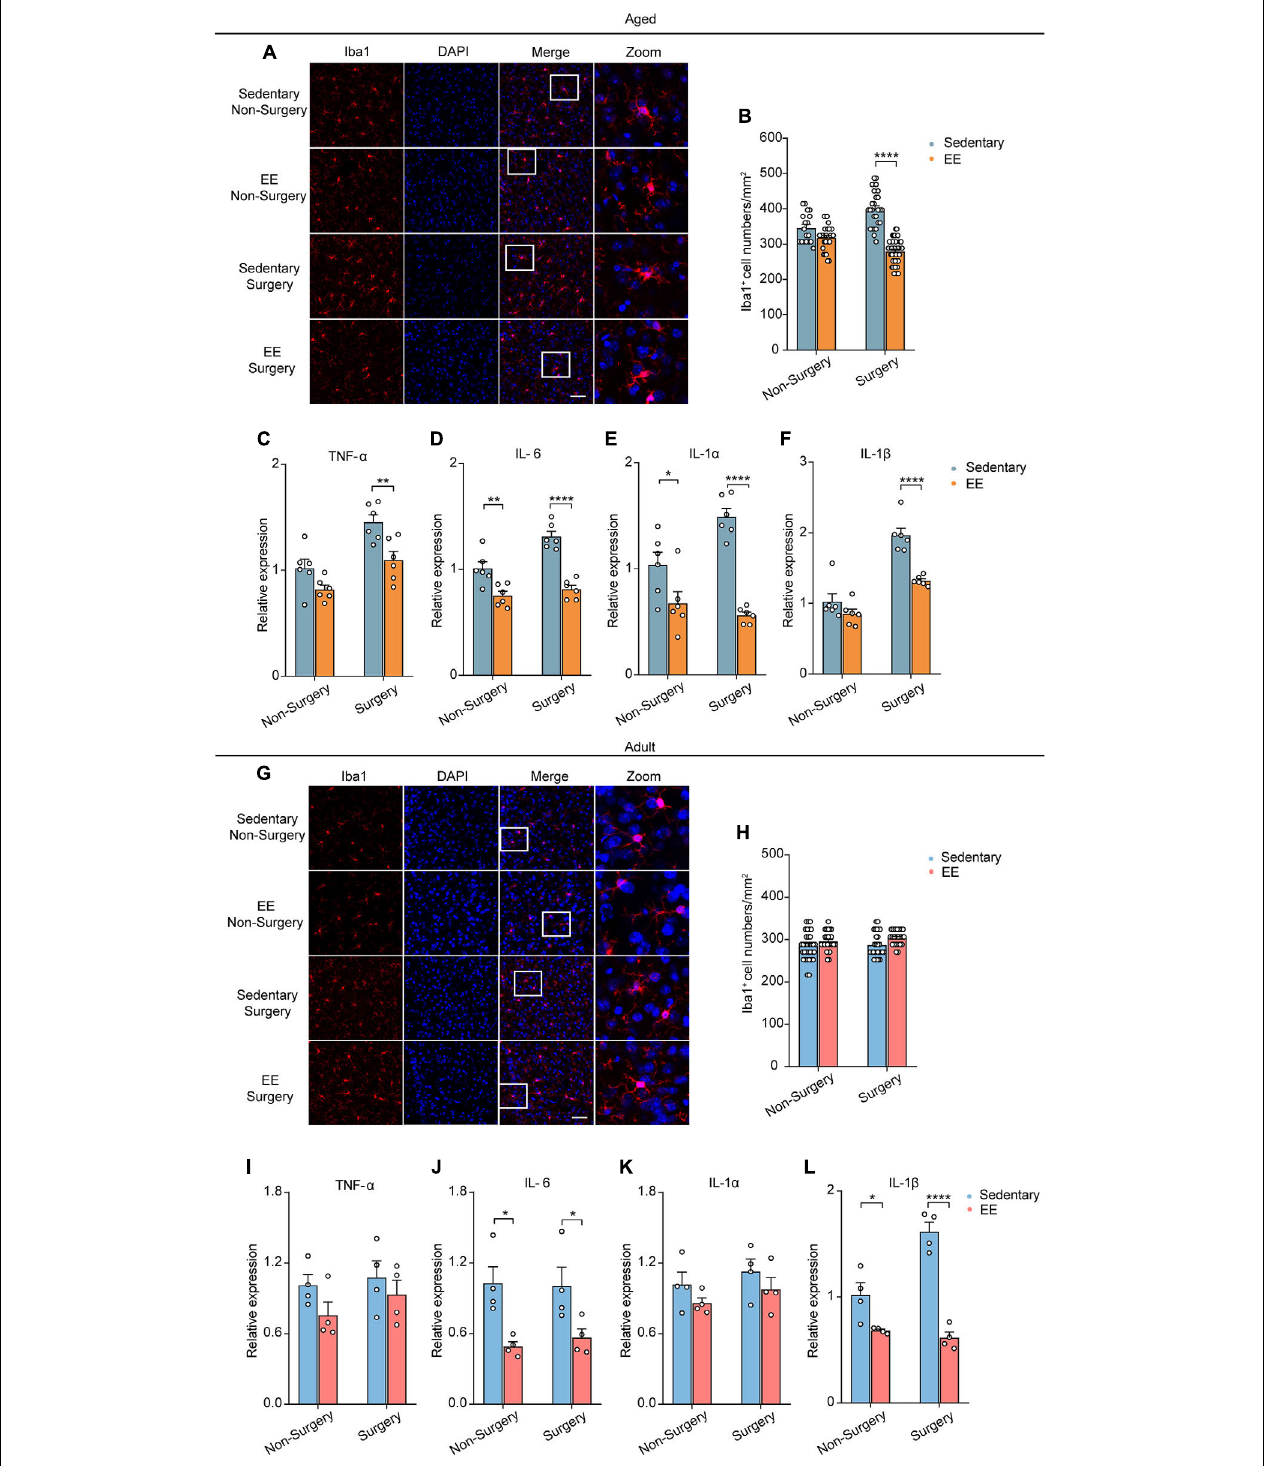
FIGURE 5 | EE prevented the exaggerated neuroinflammation induced by surgery in the aged mice. (A) Representative images of Iba1 + microglia in mPFC of the aged mice in each group. Scale bars: 50 µ m. (B) Quantification of Iba1 + cell numbers in each group of the aged mice. (C–F) Expression level of TNF- α (C) , IL-6 (D) , IL-1 α (E) and IL-1 β (F) in each group ( n = 6 mice). (G) Representative images of Iba1 + microglia in mPFC of the adult mice in each group. Scale bars: 50 µ m. (H) Quantification of Iba1 + cell numbers in each group for the adult mice. (I–L) Expression level of TNF- α (I) , IL-6 (J) , IL-1 α (K) and IL-1 β (L) in each group ( n = 4 mice). Data was presented as mean ± SEM. Data was analyzed by two-way ANOVA and Bonferroni’s correction; *P < 0.05, **P < 0.01, ****P < 0.0001.